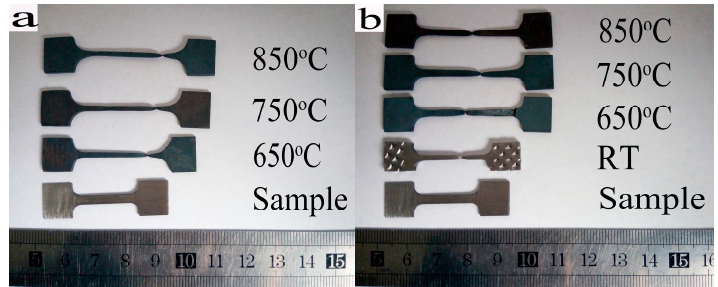
Figure 2. The tensile specimens with different temperature and strain rate: ( a ) 5 × 10 − 4 s − 1 ; ( b ) 1 × 10 − 4 s − 1 .